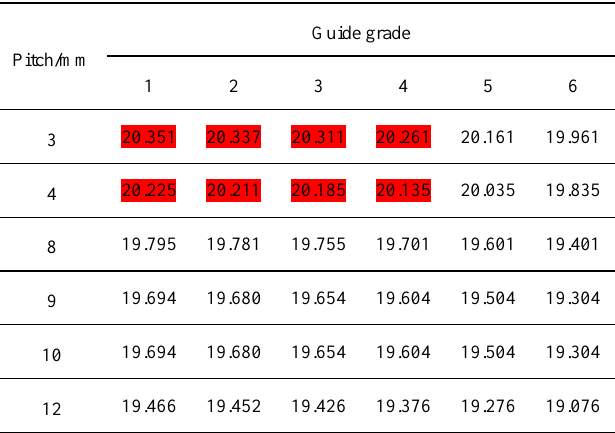
Table 9. Available height of rail grade 9(mm)